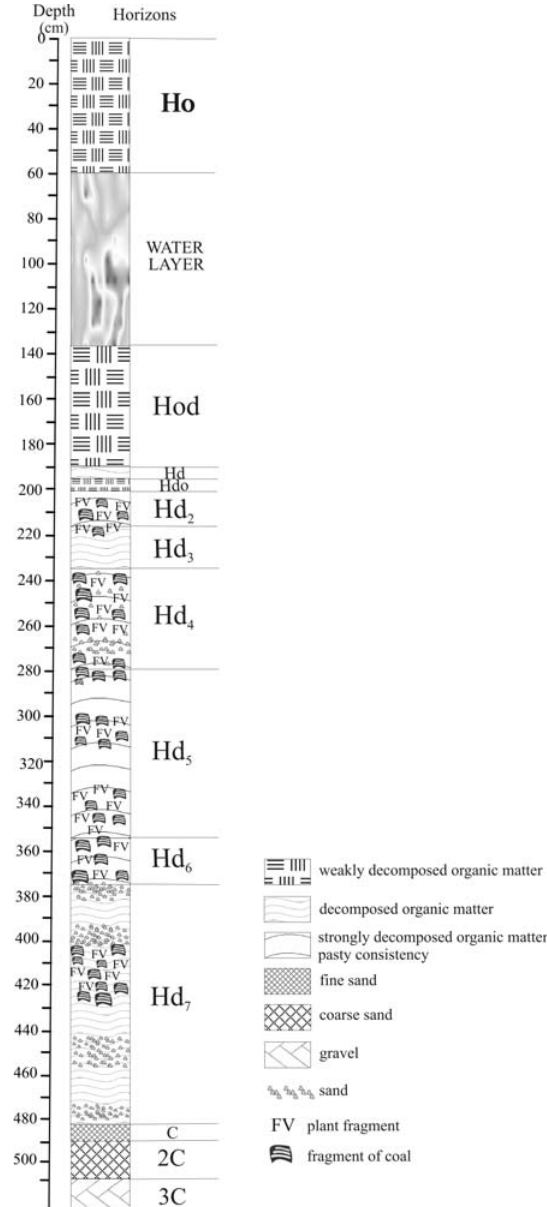
Figure 2. Representative diagram of the horizon distribution in the profile of the peatland from Pau-de-Fruta